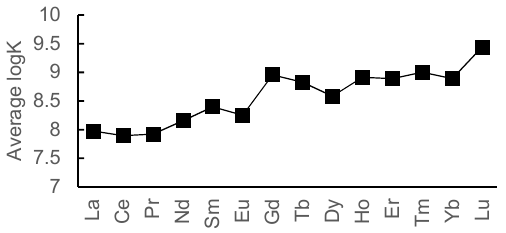
Figure 2. Average logK values for 1:1 complexes.